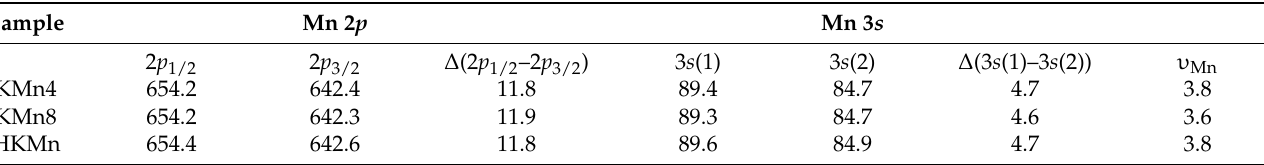
Figure 3. XPS spectra of KMn8, KMn4 and HKMn: ( a ) Mn 2 p region and ( b ) Mn 3 s region. Table 2. Binding energies (eV) for Mn 2 p and Mn 3 s core level components of XPS spectra of the samples.